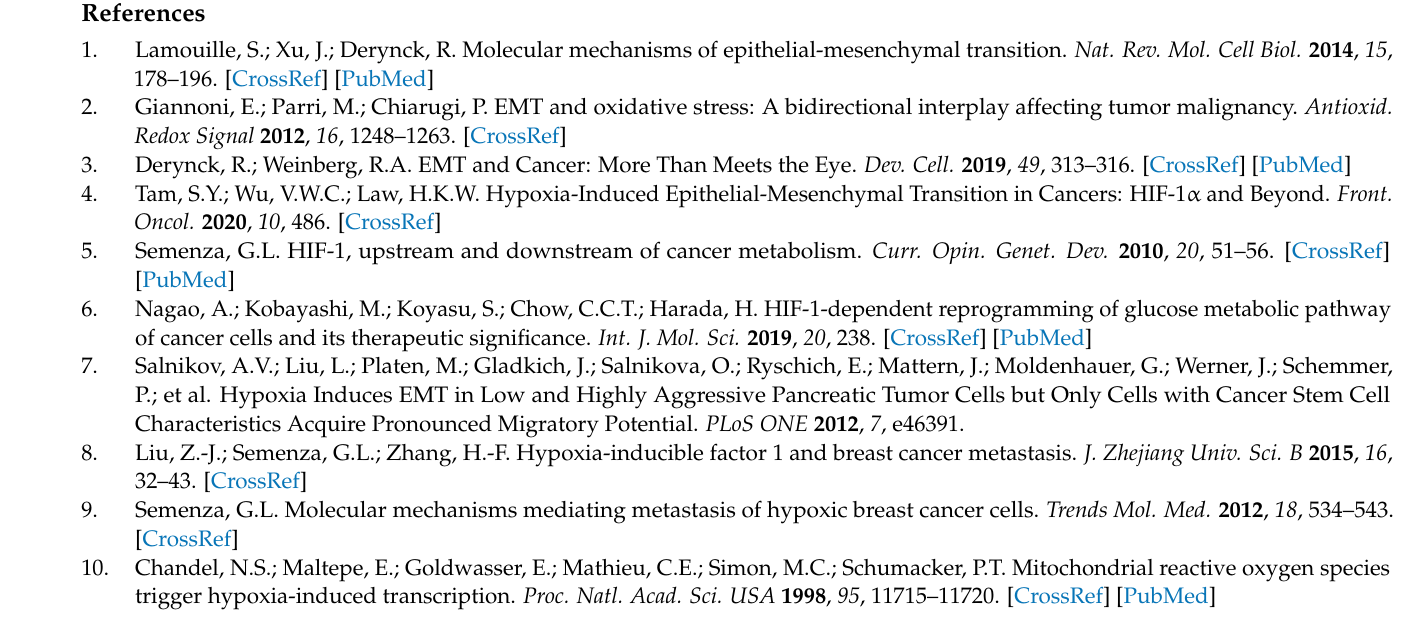
Figure S4—Effects of Myxo (1 mM) treatment and 48 h incubation in normoxia (O 2 21%) or hypoxia (O 2 1%) on MDA-MB468 viability (mean ± S.E. of 3 independent experiments); Figure S5—Effects of Ter (25 mM) treatment and 48 h incubation in normoxia (O 2 21%) or hypoxia (O 2 1%) on